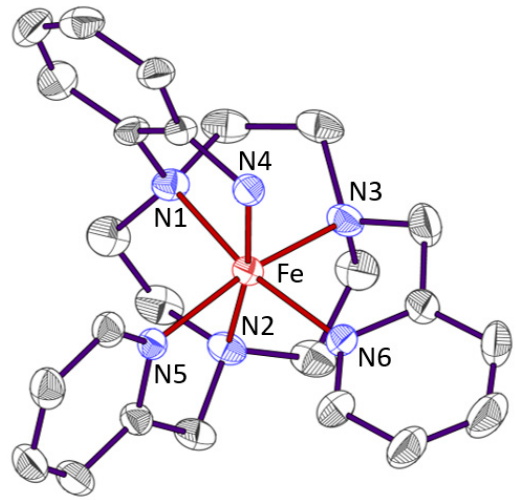
Figure 1. ORTEP [72] view of the cationic complex in [FeL6](ClO 4 ) 2 ( 1 ) showing thermal ellipsoids at 50% probability level, the atom labelling scheme and the coordination environment of the Fe(II) ion.